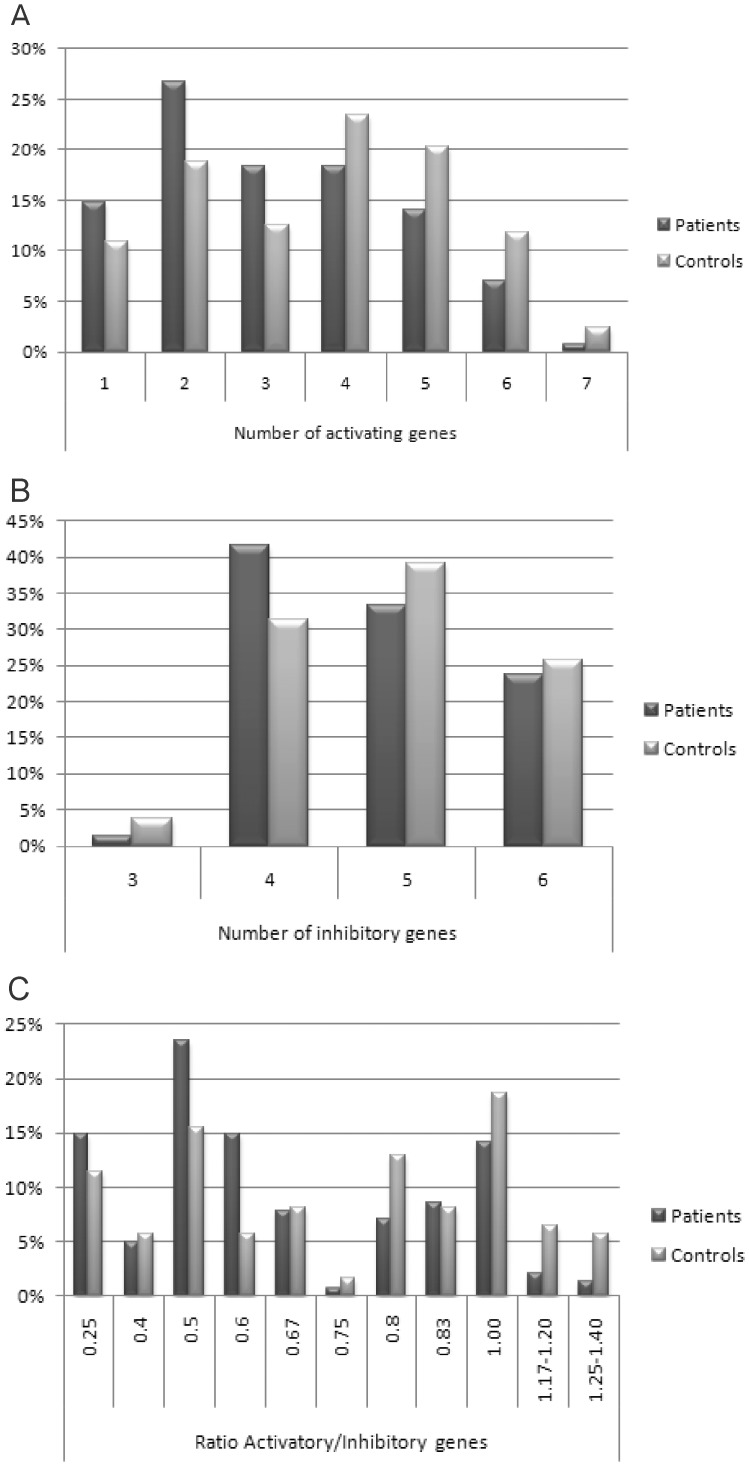
Frequency of the number of activating and inhibitory KIR genes in patients and controls.Only the Euro population was considered. (A) KIR2DL4 was counted as activating gene and the deleted KIR2DS4 was not counted as activating or inhibitory. Significant negative association was found for the presence of more than 3 activating genes (OR  = 0.49; 95% CI = 0.30–0.79; p = 0.003). (B) KIR3DL3 was not included as inhibitory. (C) Significant negative association was found for the ratio higher than 0.75 (OR  = 0.44; 95% CI  = 0.27–0.73; p = 0.001).